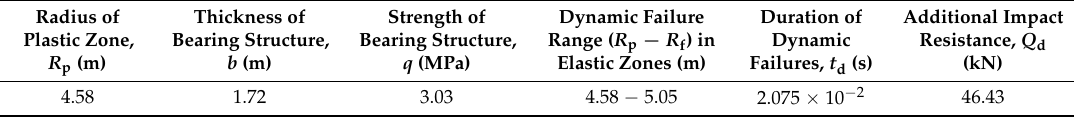
Table 5. Calculation results of a roadway rockburst based on the dynamic failure analysis model (a case occurring at 19:34 p.m. on 18 April 2014 in the track roadway of LW402103). Radius of Plastic